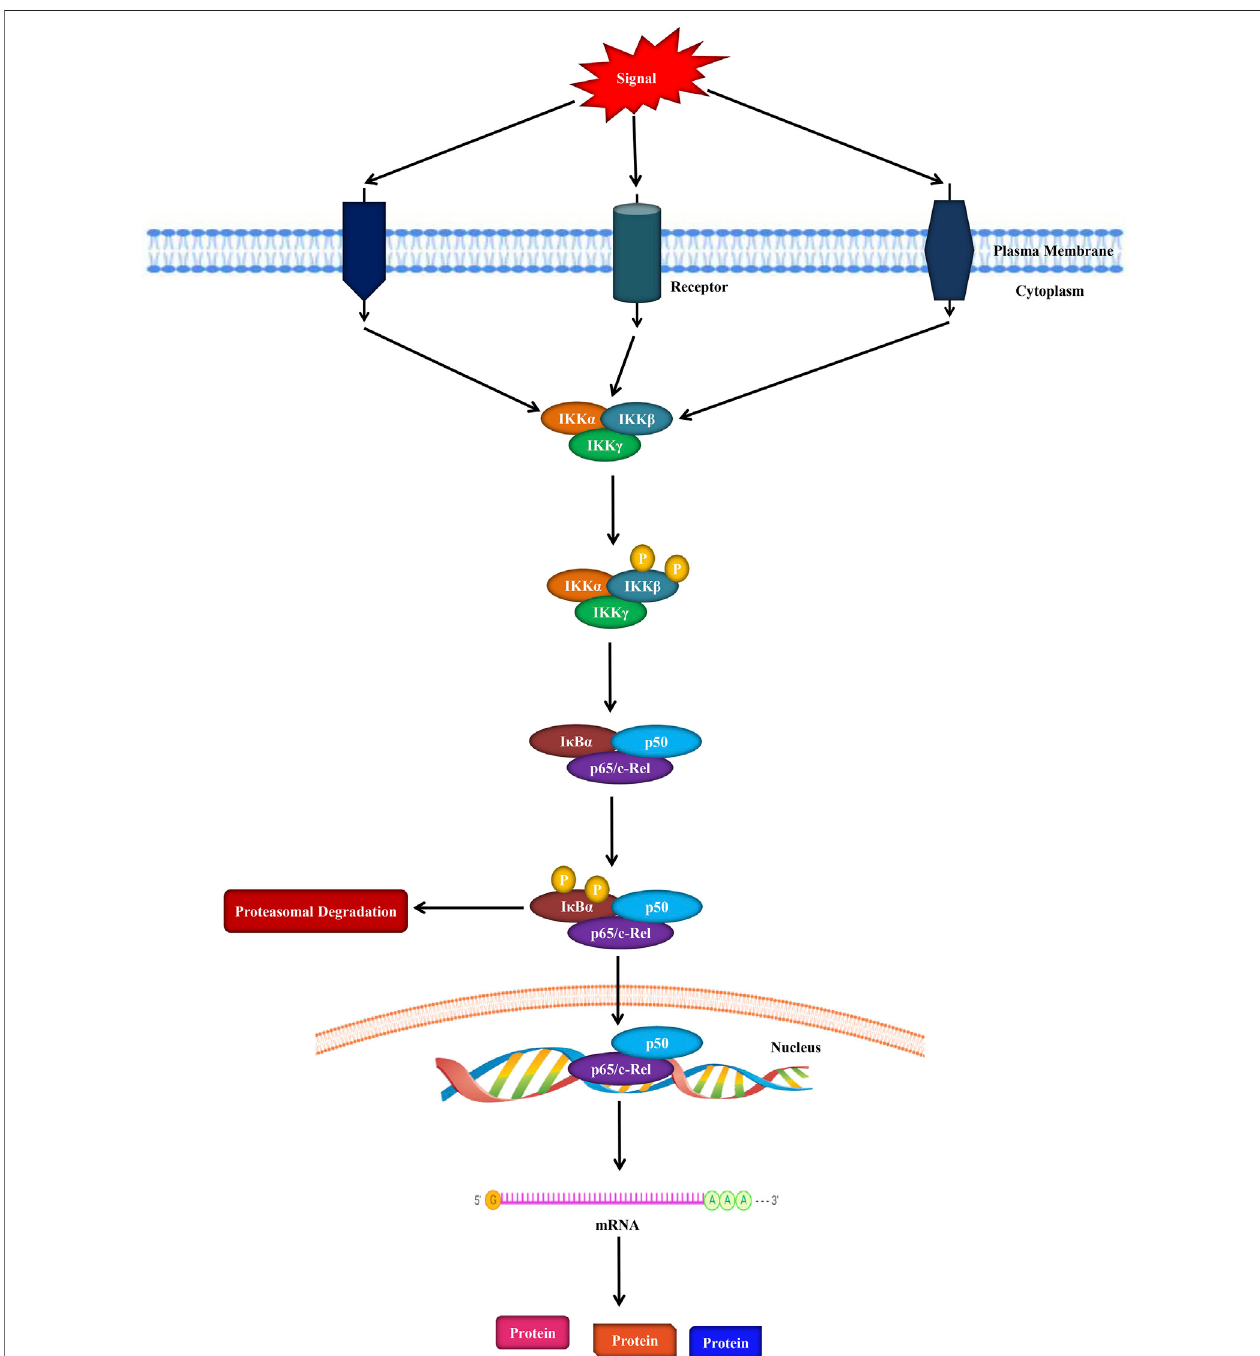
FIGURE 1 | Schematic representation of the NF- κ B signaling in